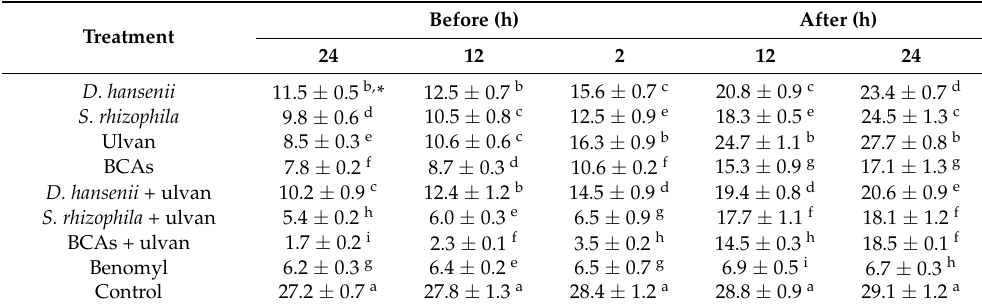
Table 3. Effect of inoculation timing of D. hansenii , S. rhizophila , and ulvan on lesion diameter (mm) by F. proliferatum on muskmelon